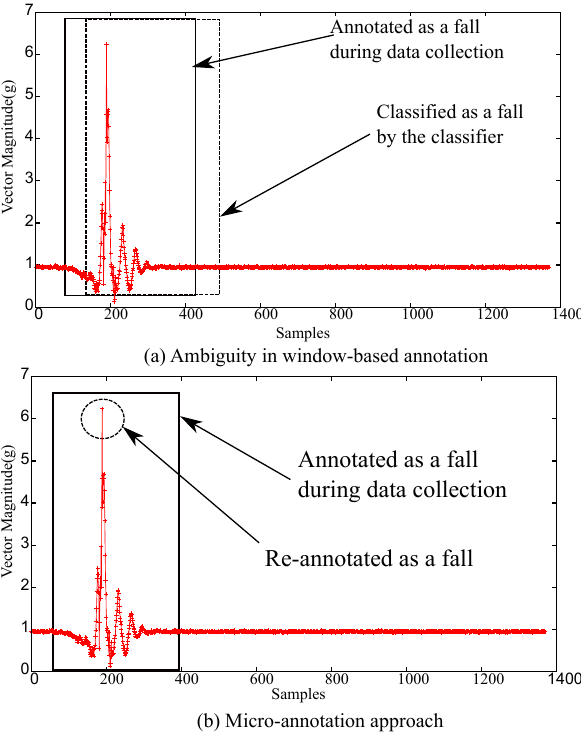
Figure 2: (a) Ambiguity in sliding window based approach; (b) Micro-annotation approach